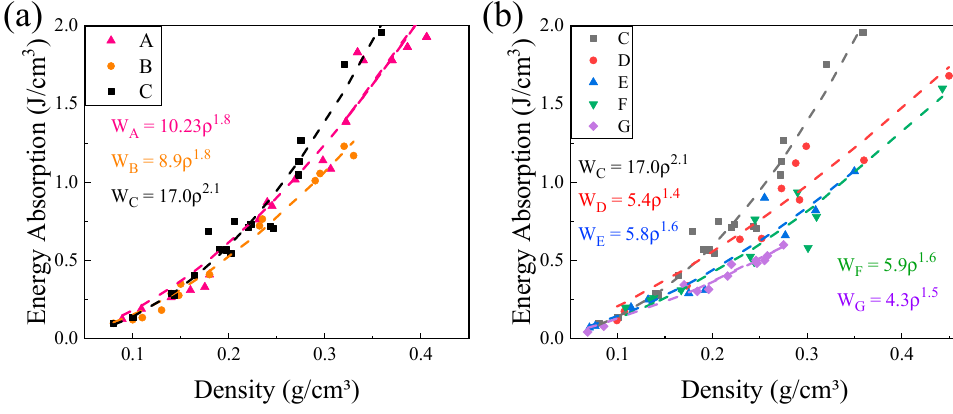
Figure 9. The relationship between the energy absorption performance of Octet hollow lattice and the length-to-diameter ratio and density ( a ) is the same length; ( b ) is a lattice of the same diameter.